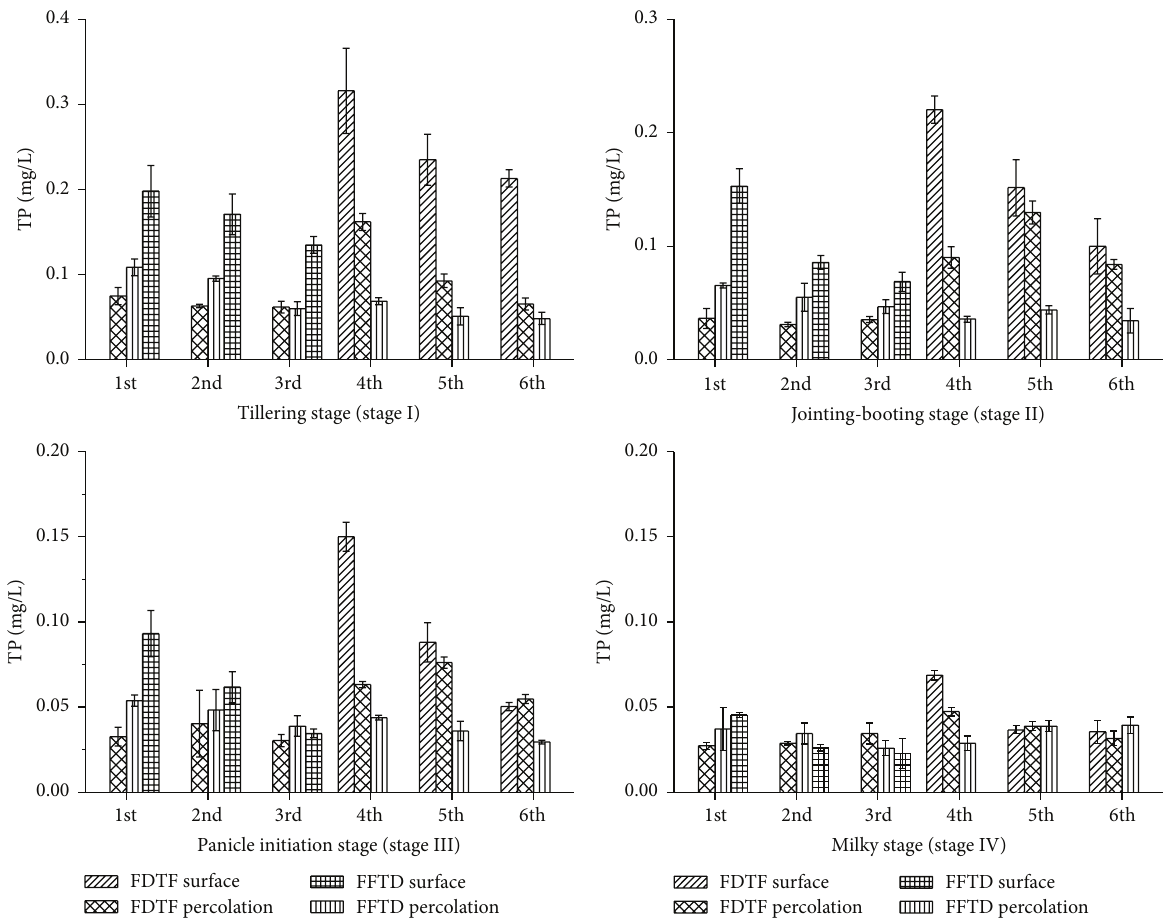
Figure 3: Change of TP concentration at each stage. FDTF indicates first drought and then flooding; FFTD indicates first flooding and then drought. 1st, 2nd, and 3rd indicate the concentration on the first, third, and fifth day of flooding for the FFTD treatments and at the water level of 0 mm, − 250 mm, and − 500 mm for the FDTF treatments. 4th, 5th, and 6th indicate the concentration on the first, third, and fifth day of flooding for the FDTF treatments and at the water level of 0mm, − 250 mm, and − 500 mm for the FFTD treatments. Vertical bars represent standard error of the